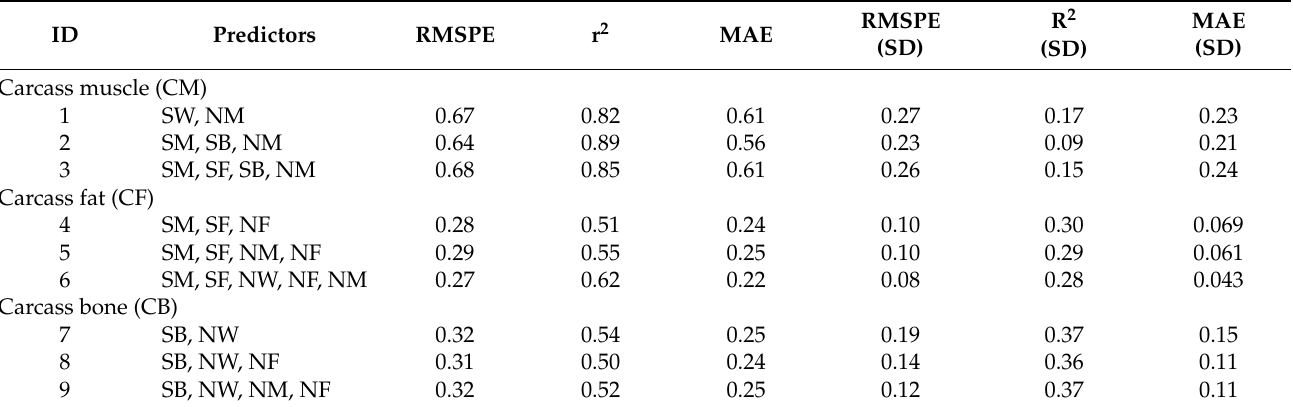
Table 4. Proposed models using k-Fold cross-validation.